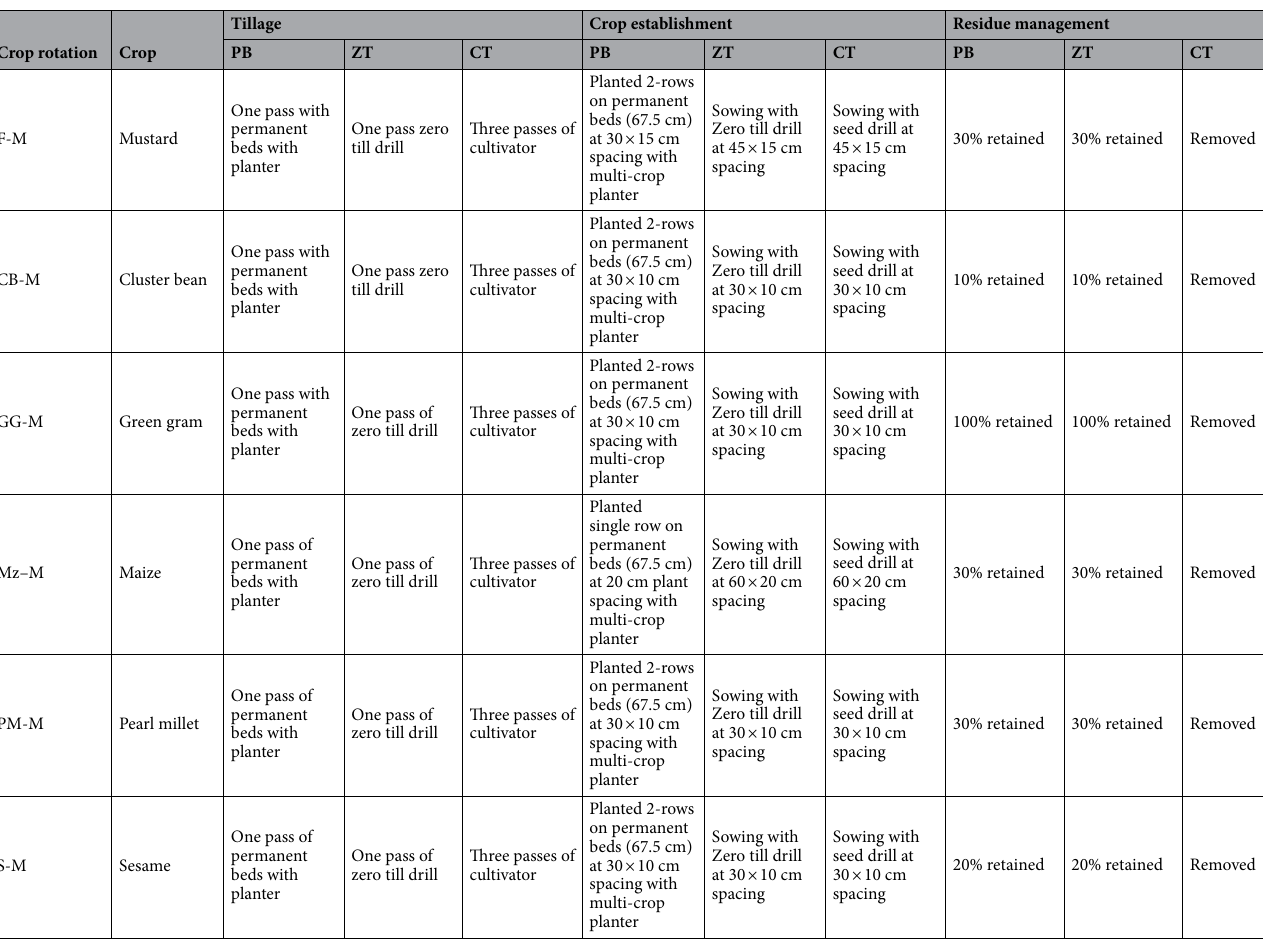
Table 7. Treatment abbreviations and description of management protocols for different crops in Indian mustard-based cropping